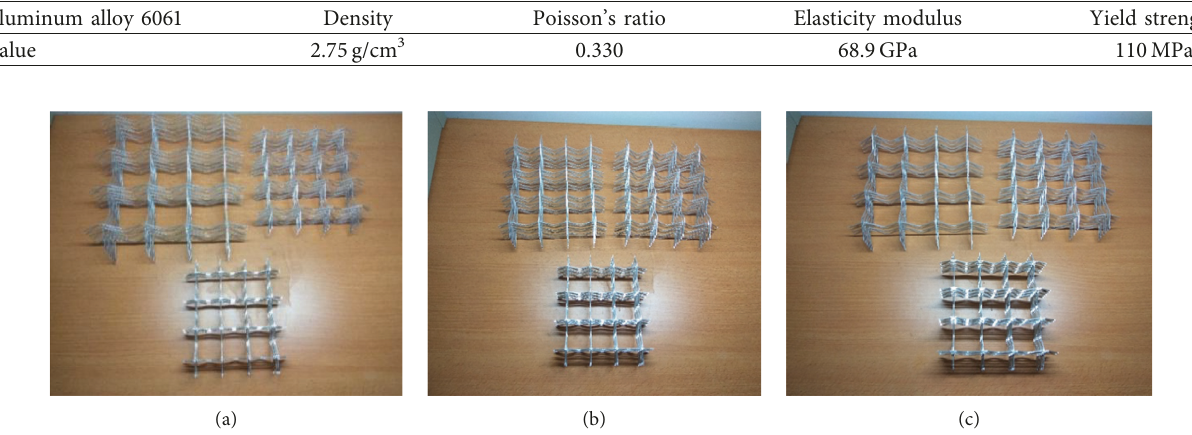
Figure 3: Unit cell plots of different samples. Table 3: Basic properties of aluminum alloy 6061.